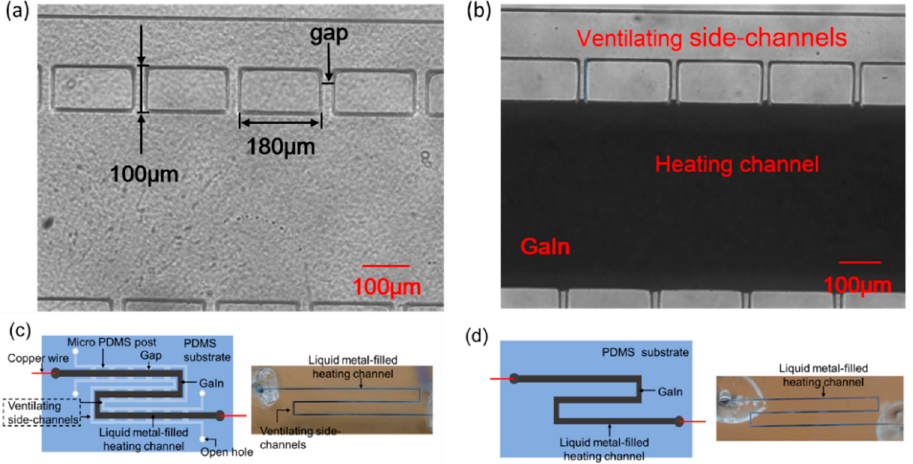
Figure 1. Microstructure of the soft microheater ( a ) before and ( b ) after injectinge GaIn. S-shaped liquid metal-based microheater ( c ) with and ( d ) without the parallel ventilating side-channels.